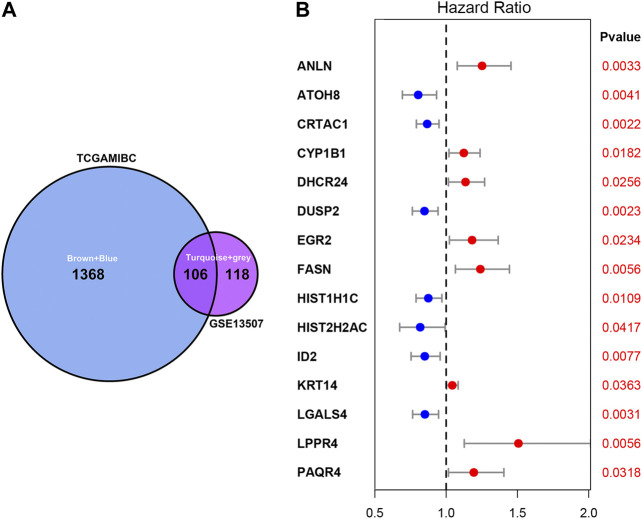
Venn plot of overlapping genes and forest plot of prognosis-related genes in MIBC. (A) The intersection of the Venn plot is considered to be co-expressed genes. (B) Forest plot shows the distribution of prognosis-related genes hazard ratios in TCGAMIBC. The red point indicates the high hazard ratio, and the blue point indicates the low hazard ratio. p-value < 0.05 is regarded as significant and identified by the red font.